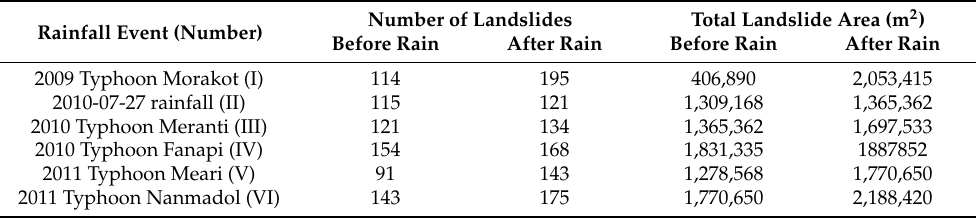
Figure 3. dr / dt , ds / dt , and the change in landslide area before (left) and after (right) Typhoon Morakot (2009) ( a ), heavy rain on July 27, 2010 ( b ), Typhoon Meranti (2010) ( c ), Typhoon Fanapi (2010) ( d ), Typhoon Meari (2011) ( e ), and Typhoon Nanmadol (2011) ( f ) in the study area, The data is obtained from [14]. Table 6. Number and area of landslides before and after different rainfall events in the study